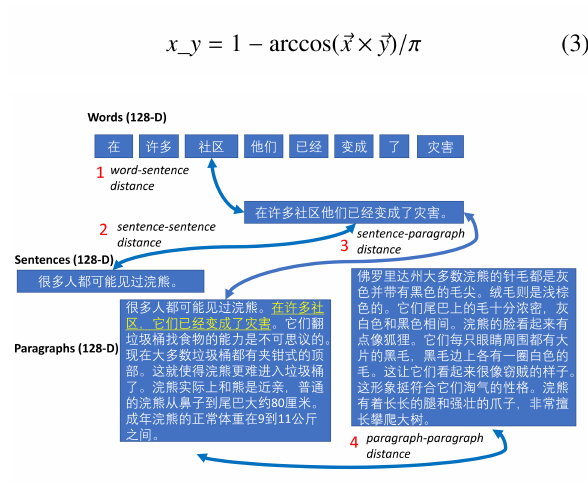
Figure 4. Measures of similarity at multiple scales